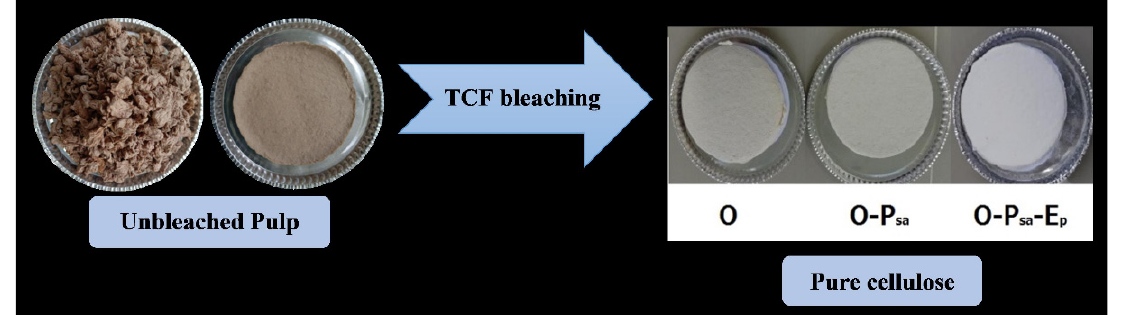
Figure 7. Transformation of the Nypa fruticans unbleached pulp into pure cellulose during three-stage totally chlorine-free bleaching at 20% AA dosage (O: oxygen; P sa : peroxymonosulfuric acid; E p : alkaline hydrogen peroxide).